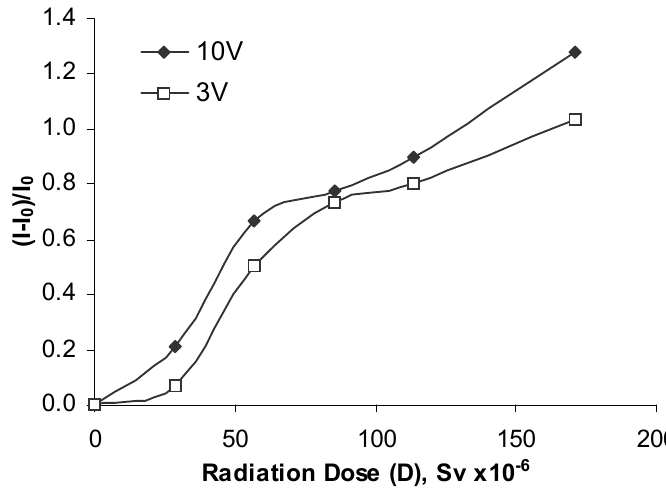
)/I with dose under the applied voltages of 10 V and 0 0